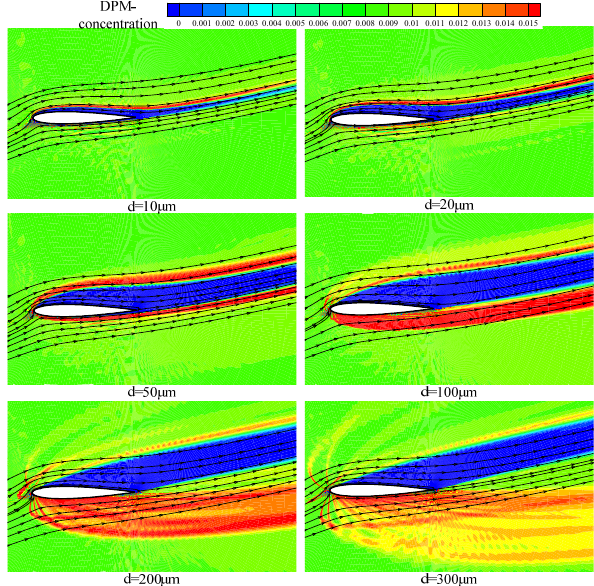
Figure 11. Streamline and mass concentration distribution under different diameter particles.